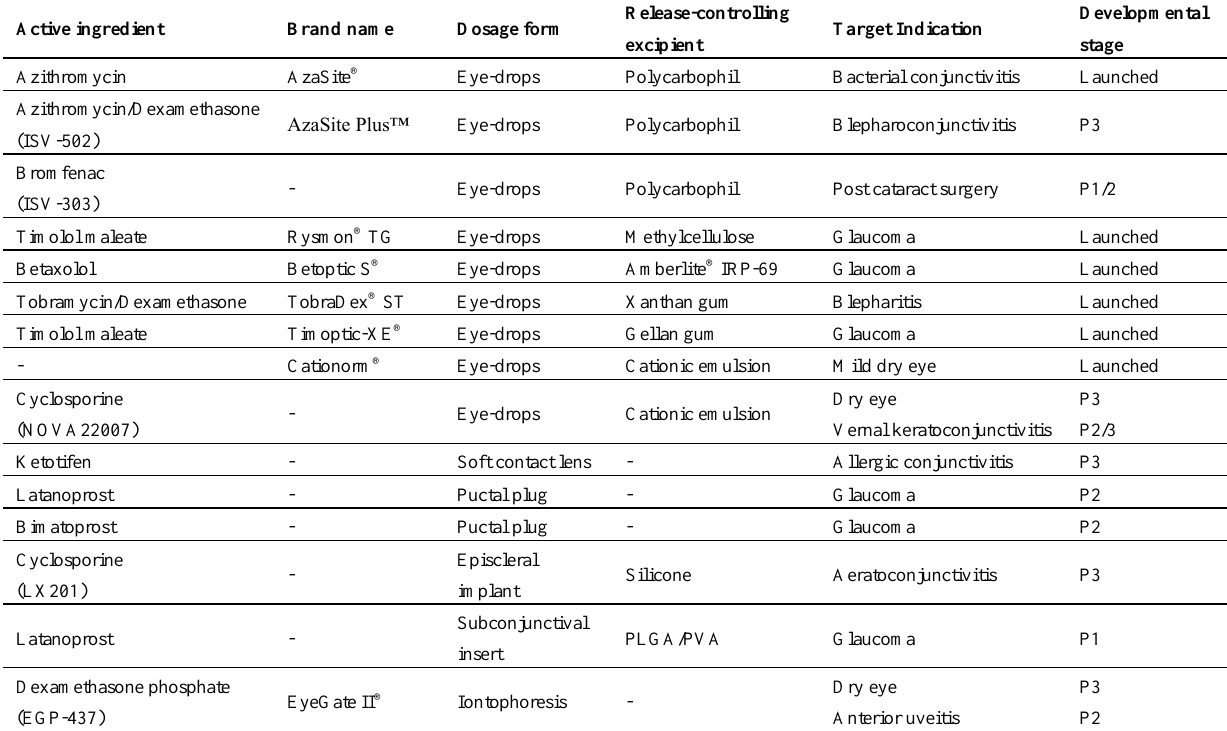
Table 1. Current and future drugs in clinical trials for anterior DDSs.